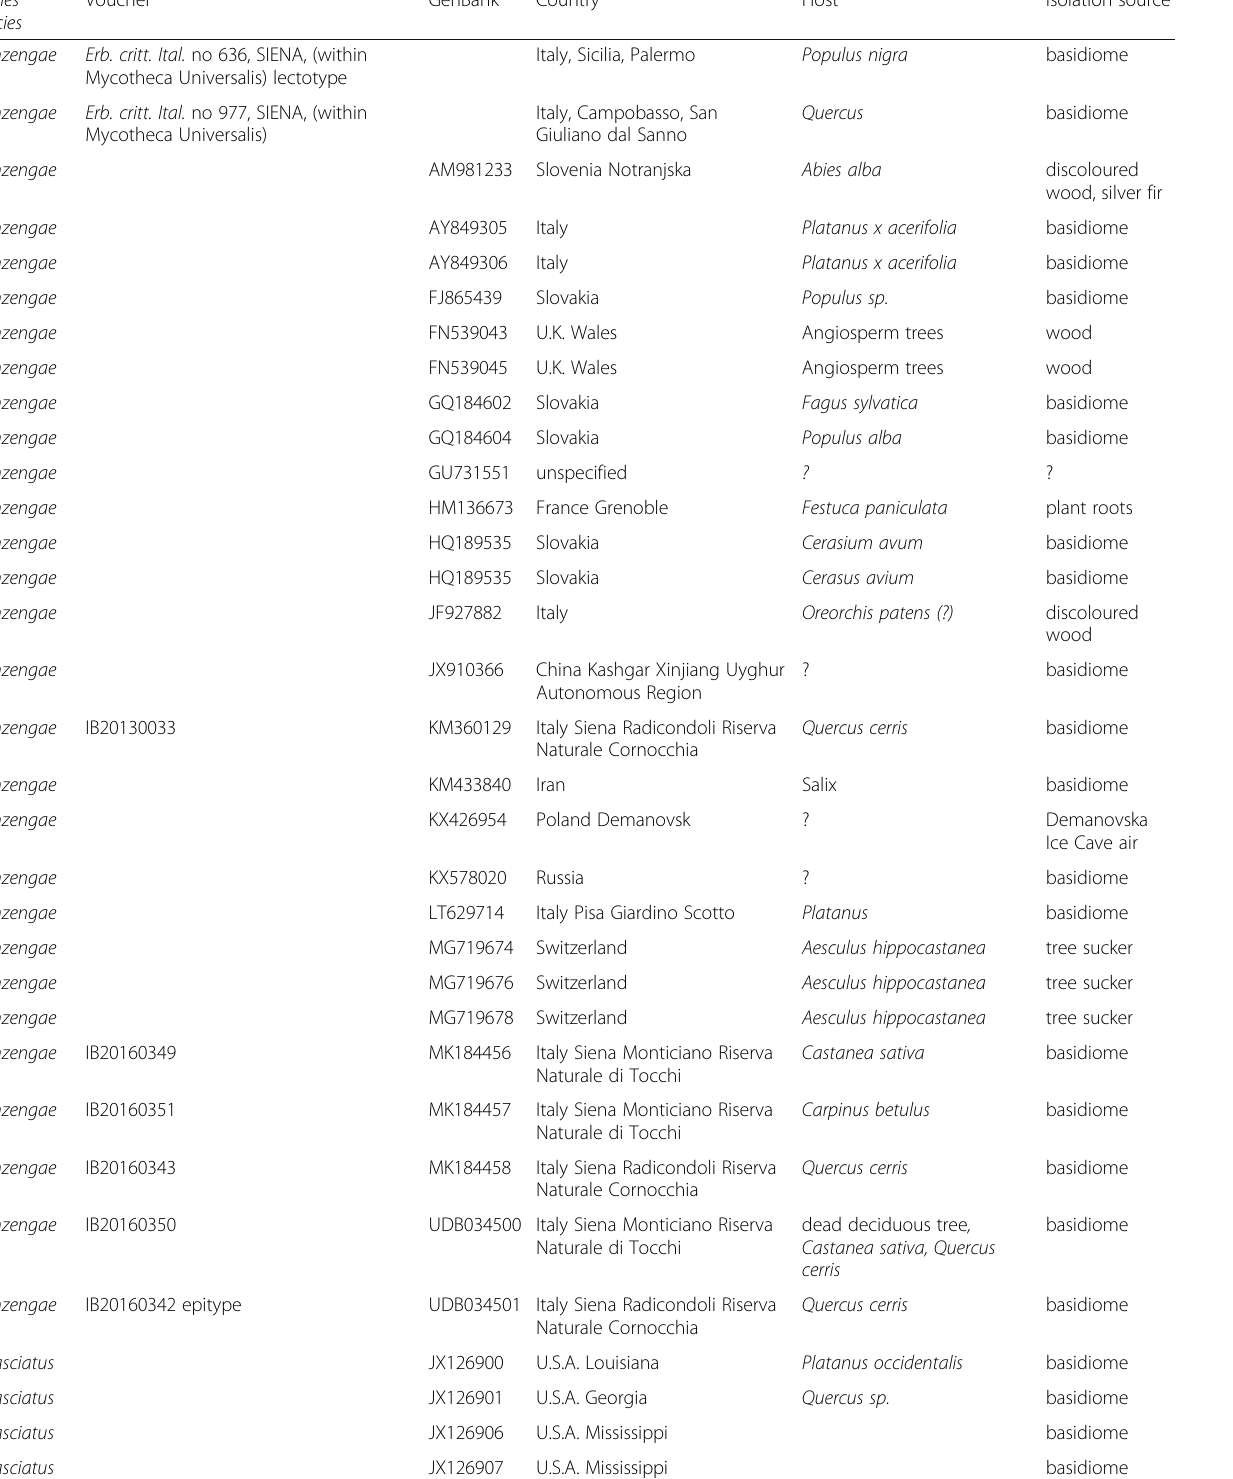
Table 1 Fomes sequences included in the phylogenetic analysis with information on the species identification, the newly sequenced voucher, the GenBank Accession number, and available information on geographic provenance as well as on host plant and isolation source. Sorted based on GenBank Accession number within